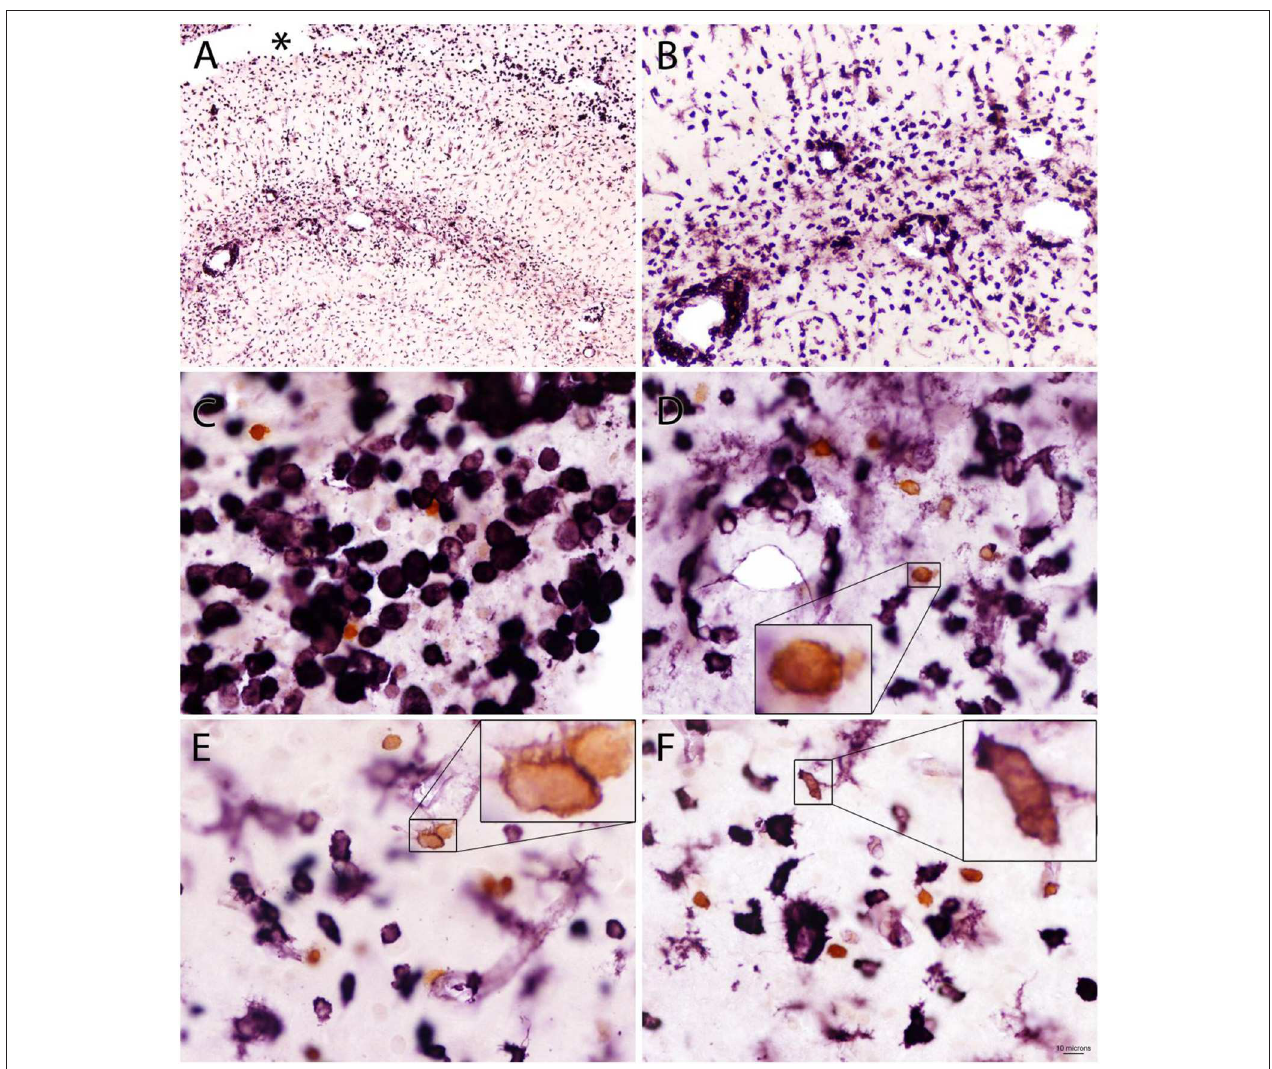
FIGURE 9 | Double staining for Quin-IR (orange chromogen) and GSL-IB 4 lectin staining (purple chromogen) in the hippocampus 3 days after LPS injection into the hippocampus. Lectin staining showed a massive reaction from phagocytes and microglia surrounding a necrotic region (*) between hippocampus and the overlying corpus callosum (A) . Many lectin-stained cells accumulated in and around the vasculature of the hippocampus (B) . In contrast to widespread lectin staining of activated microglia and phagocytes throughout the cortex and hippocampus, only a small number of Quin-IR cells was observed (C–F) . Some of the Quin-IR cells were stained lightly at their perimeter with the lectin (insets in D–F ) but many did not have observable lectin staining. Bar in (F) , 100 µ m in (A) , 40 µ m in (B) , 10 µ m in (C–F) , and 3 µ m in